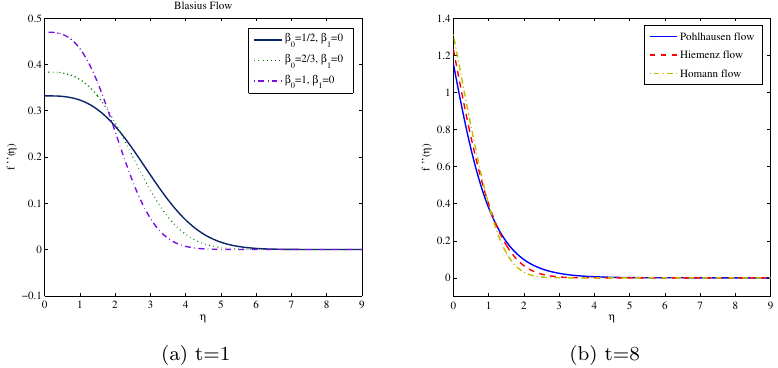
Figure 3. Shear stress of Falkner-Skan solution for the cases of: Blasius problem β 1 = 0 (left) and Pohlhausen, Hiemenz, and Homann flows β 0 = 0 , 1 , 2 , respectively, with β 1 = 1